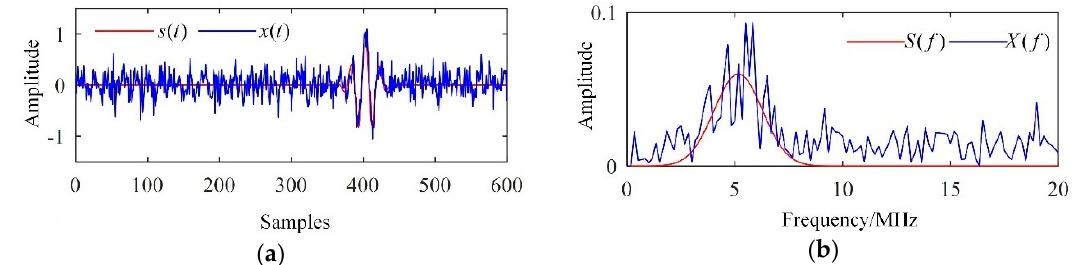
Figure 1. Simulated results. ( a ) Waveforms and ( b ) frequency spectra.